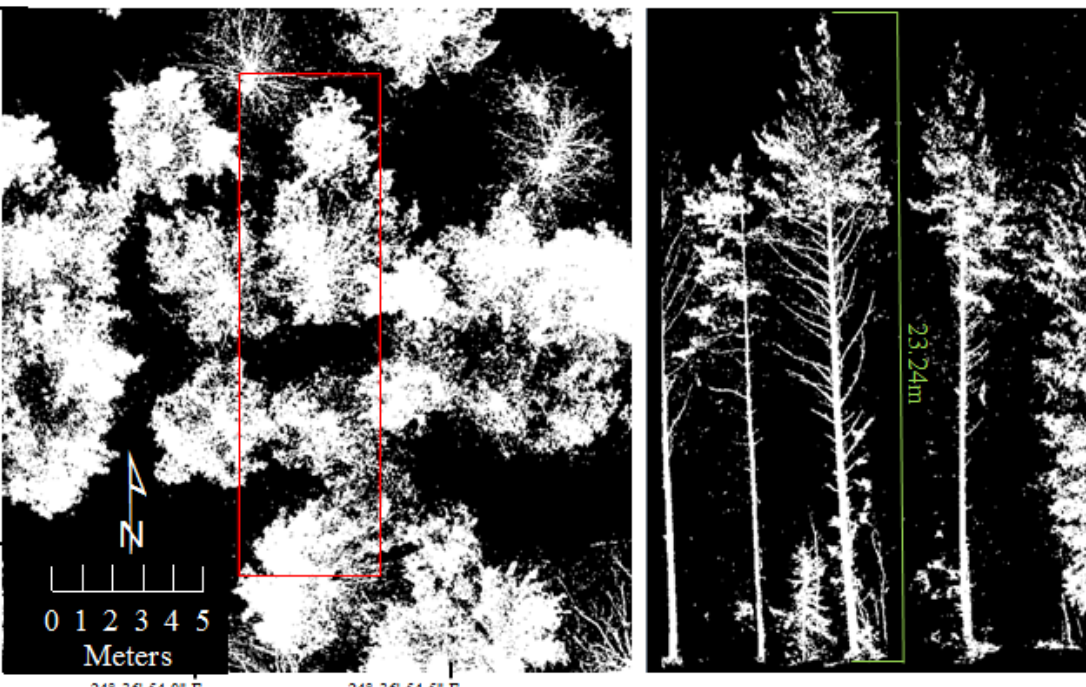
Figure 2. Example of modeled reference trees, top view on the left and side view on the right.